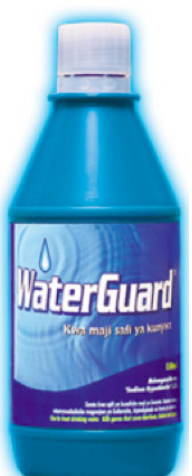
Figure 1 . 150 mL bottle of WaterGuard as sold in Kenya